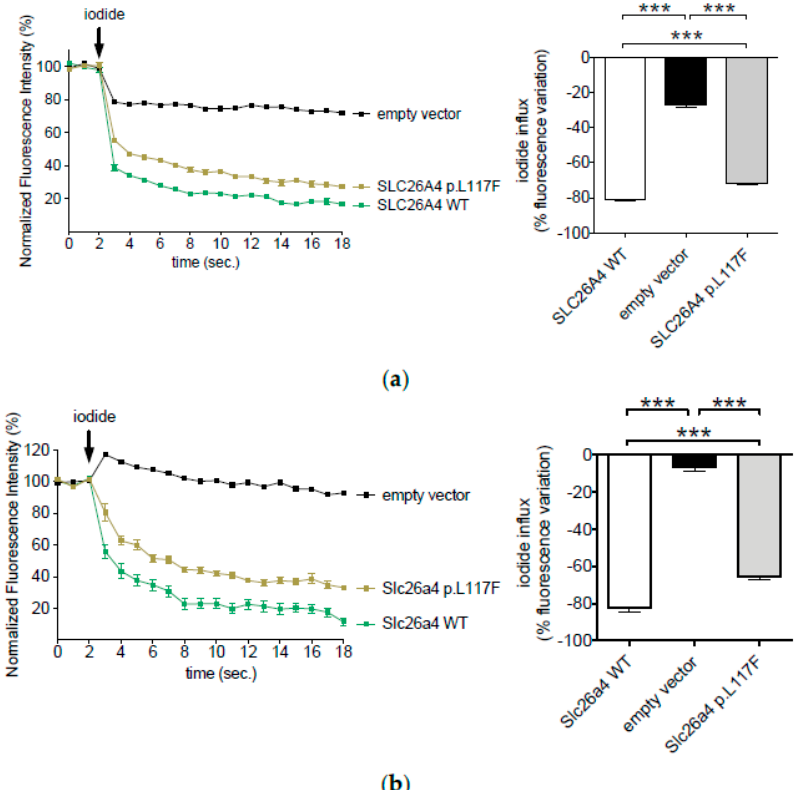
Figure 1. Ion transport activity of human ( a ) and Mus musculus ( b ) wild-type pendrin and pendrin variant p.L117F. HEK 293 Phoenix cells were co-transfected with wild-type (WT) or p.L117F pendrin, and the iodide sensor enhanced yellow fluorescent protein (EYFP) H148Q;I152L or EYFP H148Q;I152L alone (empty vector) and bathed in chloride- or iodide-containing solutions. The arrow indicates the addition of the iodide-containing solution to the bath. Left panels show the average fluorescence intensity over time normalized for the average fluorescence intensity measured in the chloride-containing solution. Right panels represent the % decrease in fluorescence intensity determined over the experimental period (19 s). n = 60 measurements from 5 independent experiments. *** p < 0.0001, one-way ANOVA with Bonferroni’s multiple comparison